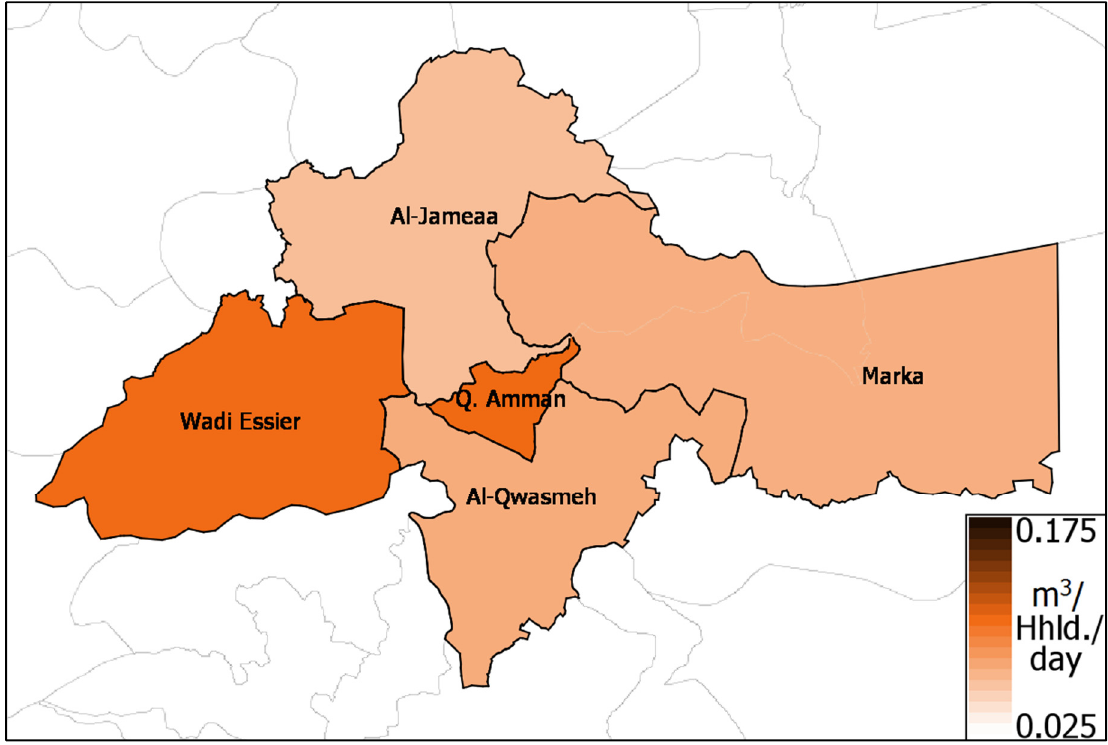
Figure 3. Tanker water distribution across low-income households in Amman’s districts under the baseline scenario, visualized with the GIS module of our NetLogo model [42]. Darker shades indicate higher consumption